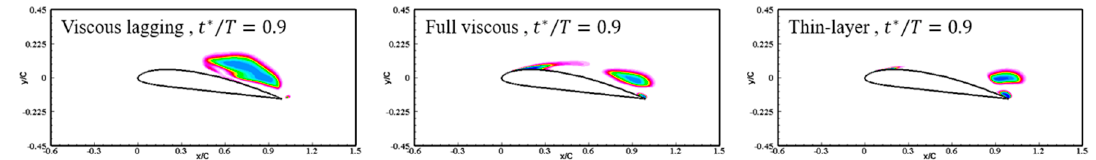
Figure 9. Comparison of instantaneous cavitation structures in the trailing edge region.